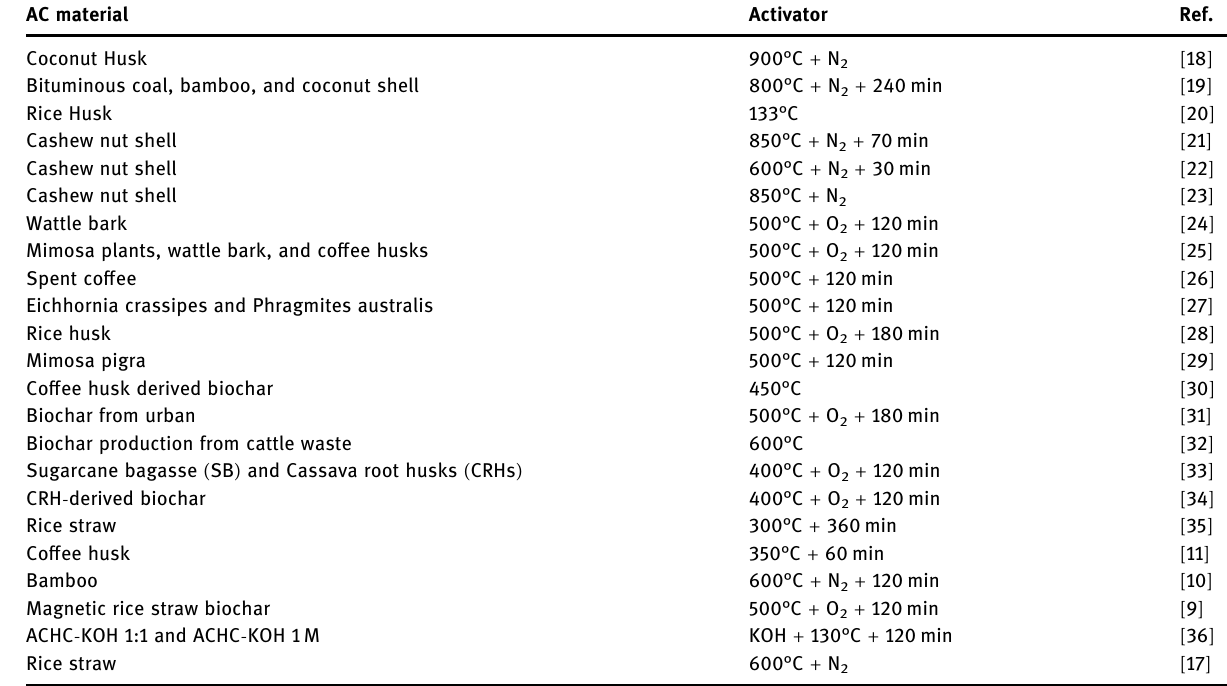
Table 1: Synthesis of AC by physical activation method AC